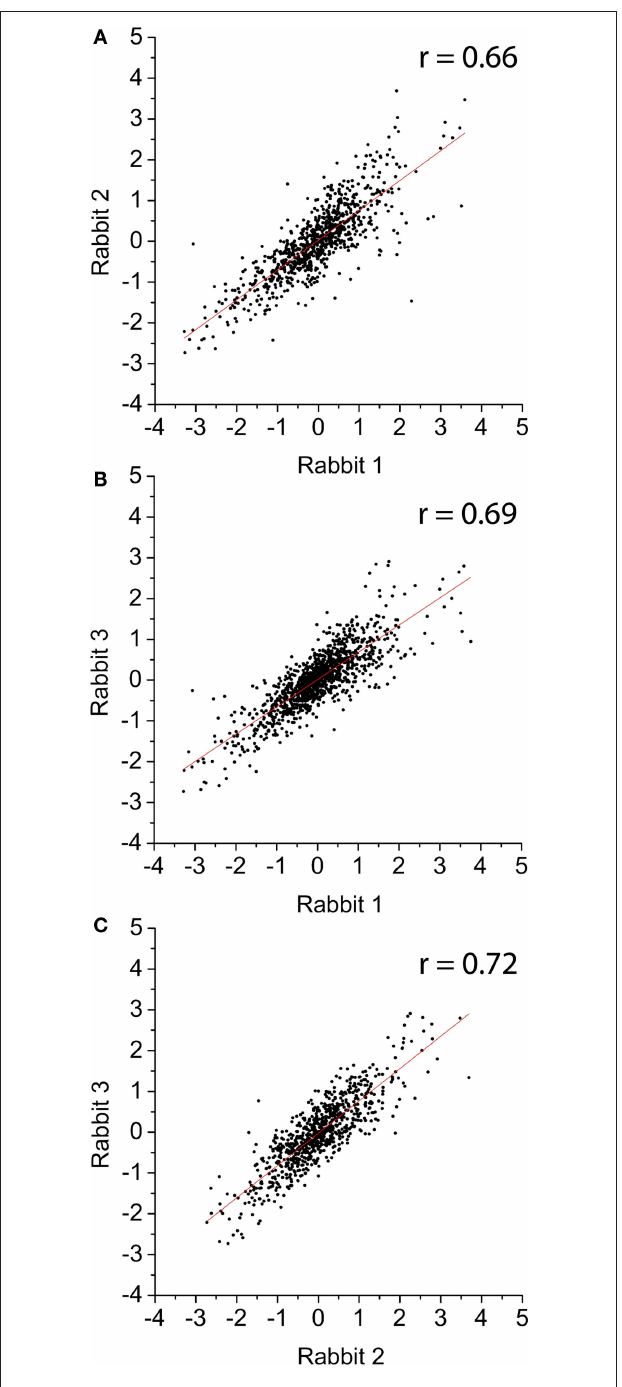
Figure 3 | Correlation between log2 values of the gene expression ratio obtained from microarray experiments using bacterial cDNA from three different rabbits: (A) rabbit 1 vs. rabbit 2; (B) rabbit 1 vs. rabbit 3; and (C) rabbit 2 vs. rabbit 3. The red line represents the linear regression fit of the data. r, correlation